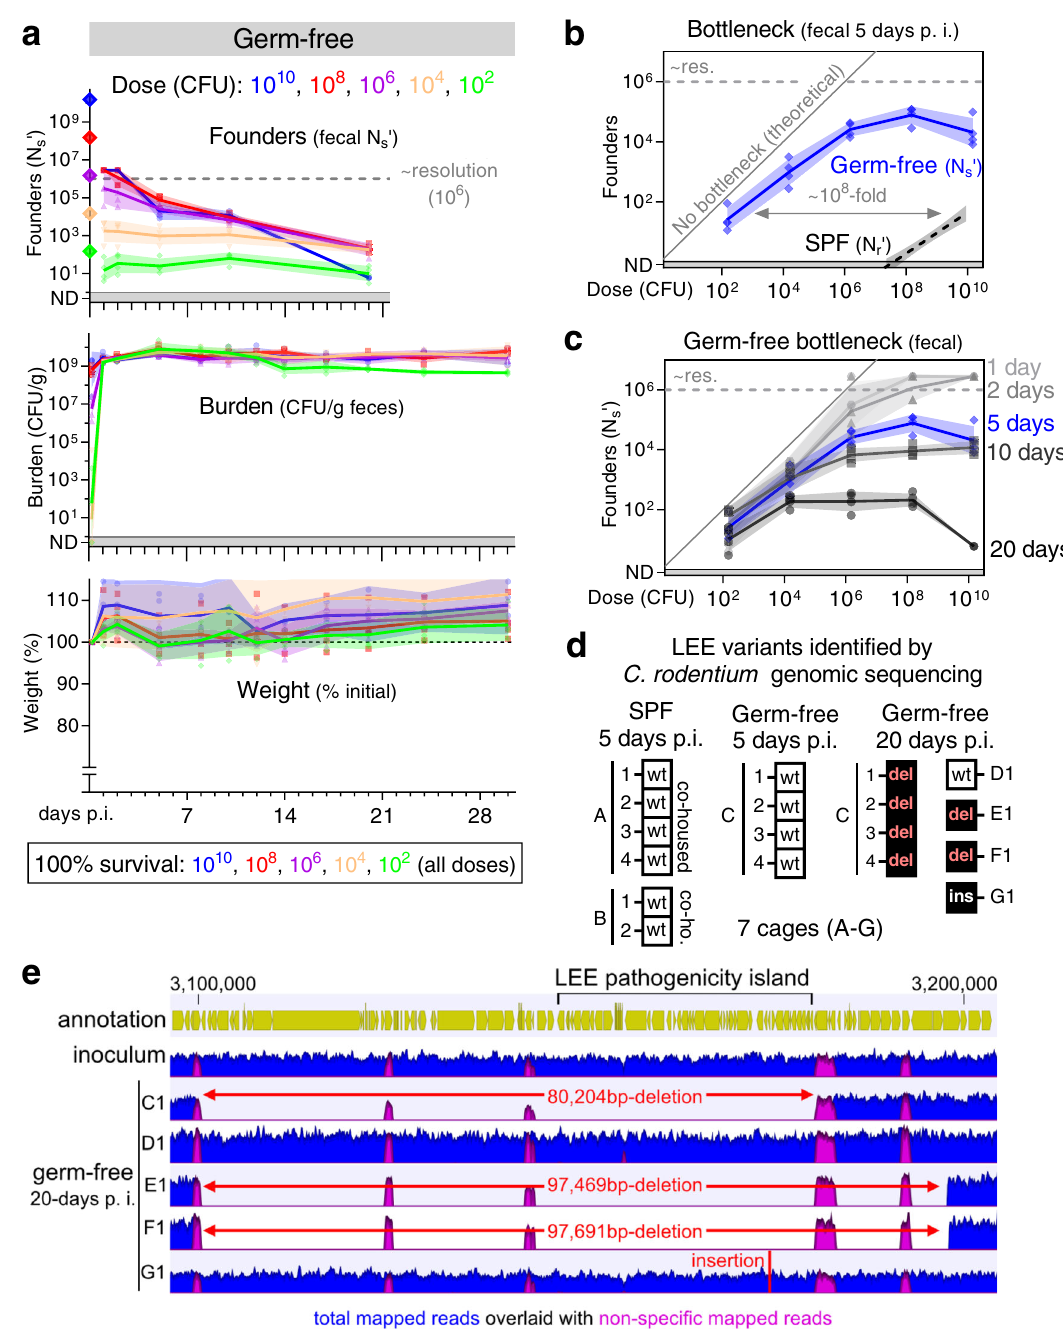
Fig. 7 | The bottleneck to C. rodentium colonization is microbiota dependent. Germ-freeC57BL/6Jmicewereorallyinoculatedwithdosesrangingfrom10 2 to10 10 CFU of STAMP-CR69K. 4 animals per dose, cohoused with animals receiving the same dose in sterile cages. Measurement of germ-free stomach acidity in Supple- mentalFig.5.SourcedataareprovidedasaSourceData fi le. a Bacterialburdenand founding population monitored in the feces (geometric means and standard deviations; resolution limit is ~10 6 founders). Animal health monitored by weight loss (percent compared to pre-inoculation; arithmetic means and standard devia- tions) and body condition. No animals became moribund. b , c Bottleneck to colonization measured by comparing dose and founders (geometric means and standard deviations). SPF B6 bottleneck data is repeated from Fig. 2 for compar- ison. d To determine if colonization was accompanied by changes in the C.